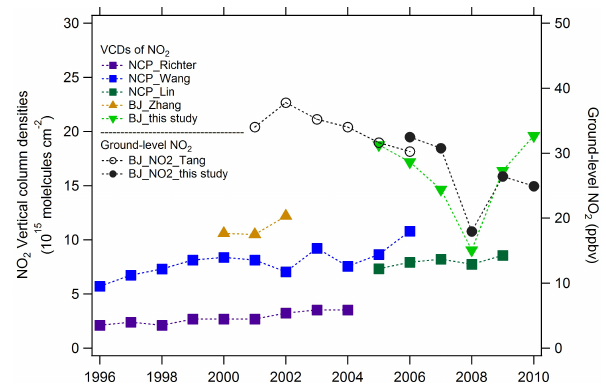
Figure 6. Variations of VCDs of tropospheric NO 2 over the North China Plain (NCP) including Beijing, compared with ground-level NO 2 mixing ratio in